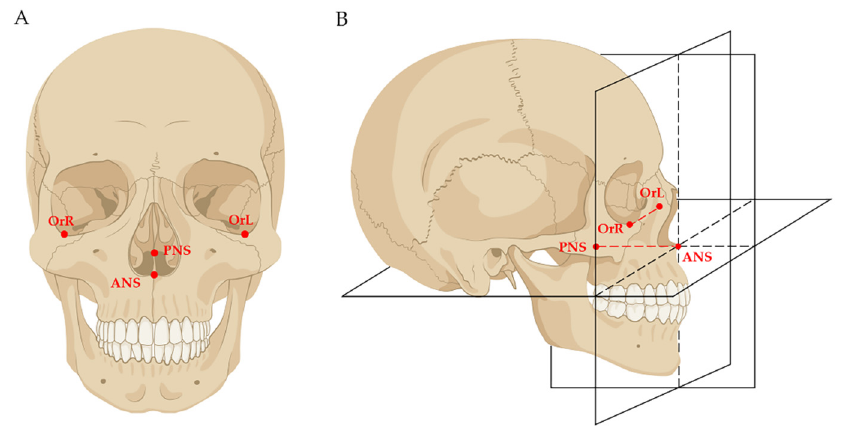
Figure 1. Schematic diagrams of the maxilla-based coordinate system: ( A ) four skeletal landmarks were selected as the basic landmarks for constructing the coordinate system, including ANS (the tip of the anterior nasal spine), PNS (the tip of the anterior nasal spine), OrL (the most inferior point of the left bony orbit), and OrR (the most inferior point of the right bony orbit); ( B ) the horizontal plane was defined as the plane passing through ANS and PNS, while parallel to the OrL–OrR line. The sagittal plane was defined as the plane passing through ANS and PNS while perpendicular to the horizontal plane. The frontal plane was defined as the plane passing through ANS while perpendicular to both the horizontal plane and the sagittal